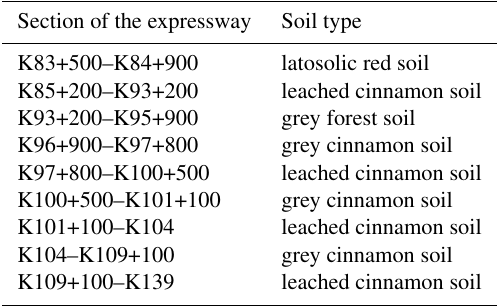
Table 1. Distribution of soil types along Xinhe Expressway. Section of the expressway